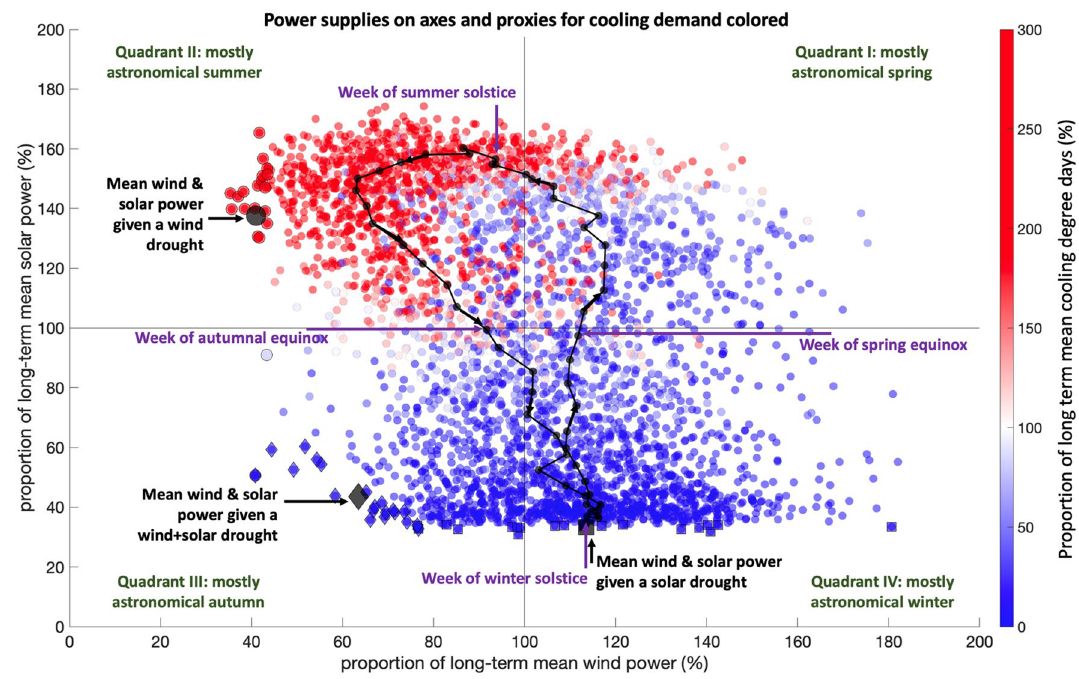
with black edge colors with wind droughts represented as circles, solar droughts represented as squares and compound wind and solar droughts represented as diamonds. An animation show- ing the degree to which there is persistence in time can be seen at https:// www. youtu be. com/ watch?v= xF8u7